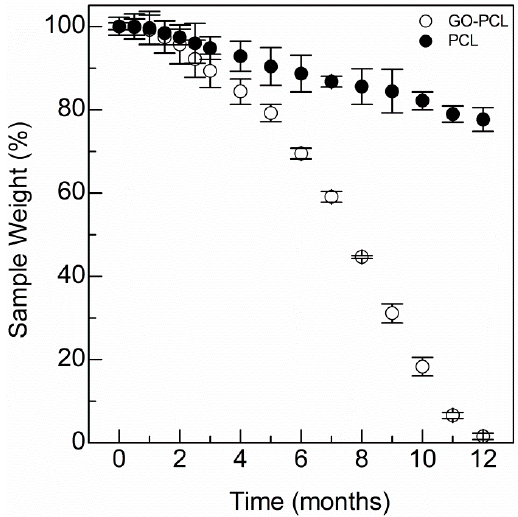
Figure 3. Degradation kinetics of the GO–PCL patch compared with the virgin PCL sample.